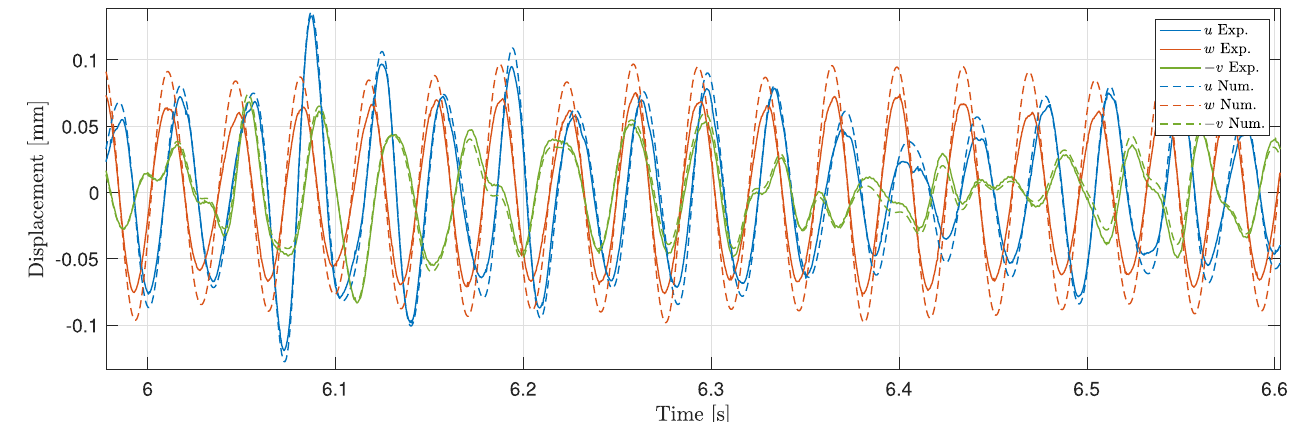
Fig. 8. Experimental (Exp.) and numerical (Num.) comparisons of displacements ( u, w ) of Node 15 and − v of Node 28 for a random base excitation.